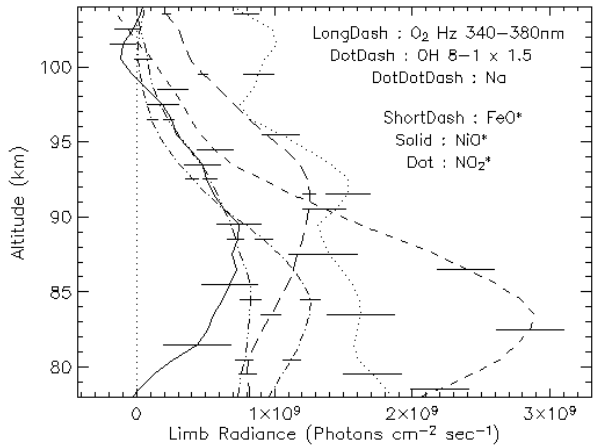
Fig. 9. Observed night airglow limb radiances obtained from aver- aged OSIRIS spectra, June and July of 2003. The O 2 Hz, OH and Na curves are the scaled amounts used to form the airglow spectrum subtracted at each altitude, e.g. panel (B) of Fig. 5. The FeO ∗ , NiO ∗ and NO ∗ curves are from the least squares fitting routine as applied 2 to the residual continuum at each altitude, e.g. panel (C) of Fig. 5. Only those emissions within the spectral range of Fig. 6 are included in the limb radiance sums. For the NiO ∗ emission the equivalent zenith differential brightness as detected from ground observations would be approximately 0.1 Rayleigh per nm, or 0.01 Rayleigh per